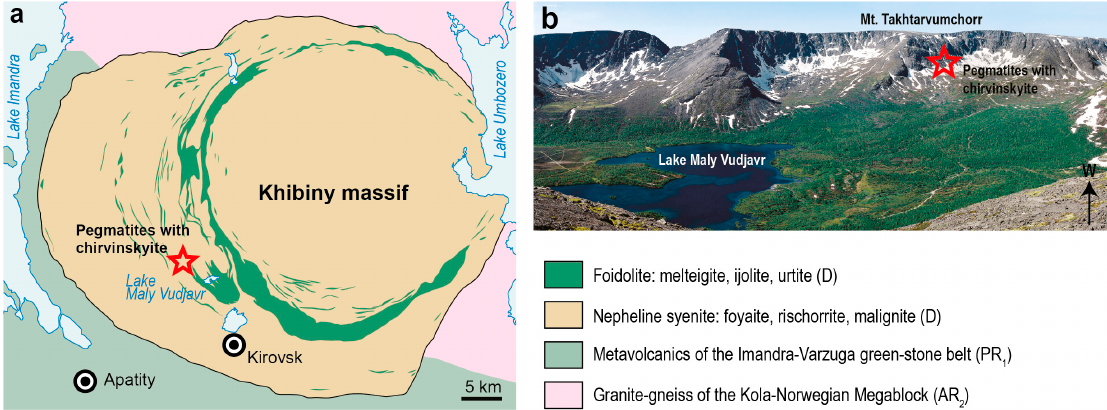
Figure 1. Geology of the Khibiny massif ( a ) and type-locality of chirvinskyite marked by the star ( b ).